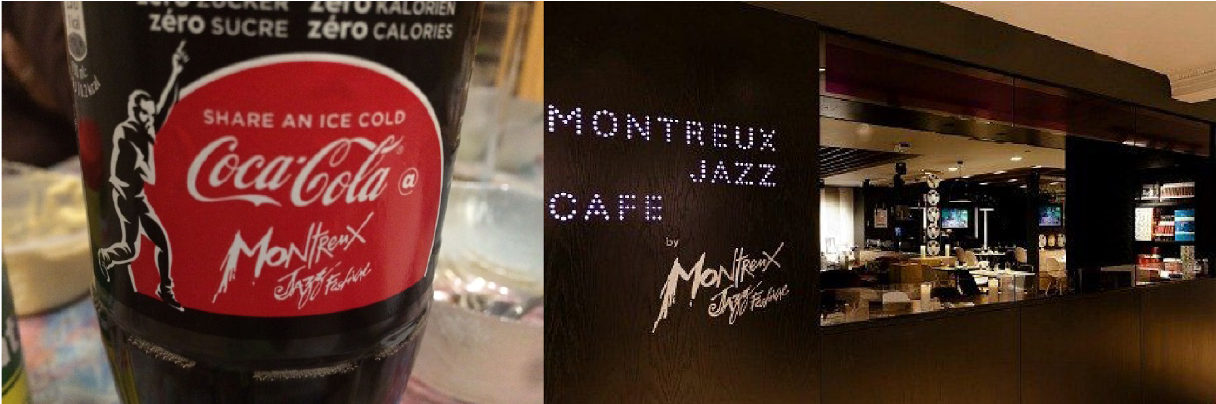
Figure 1. Bottle of Montreux Jazz Festival Coca-Cola (left) and the Montreux Jazz Café at Geneva airport (right). Urban Planning, 2020, Volume 5, Issue 2, Pages